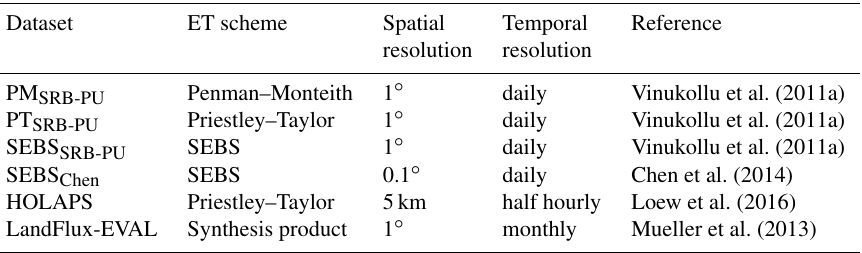
Table 1. Summary of the datasets used in our